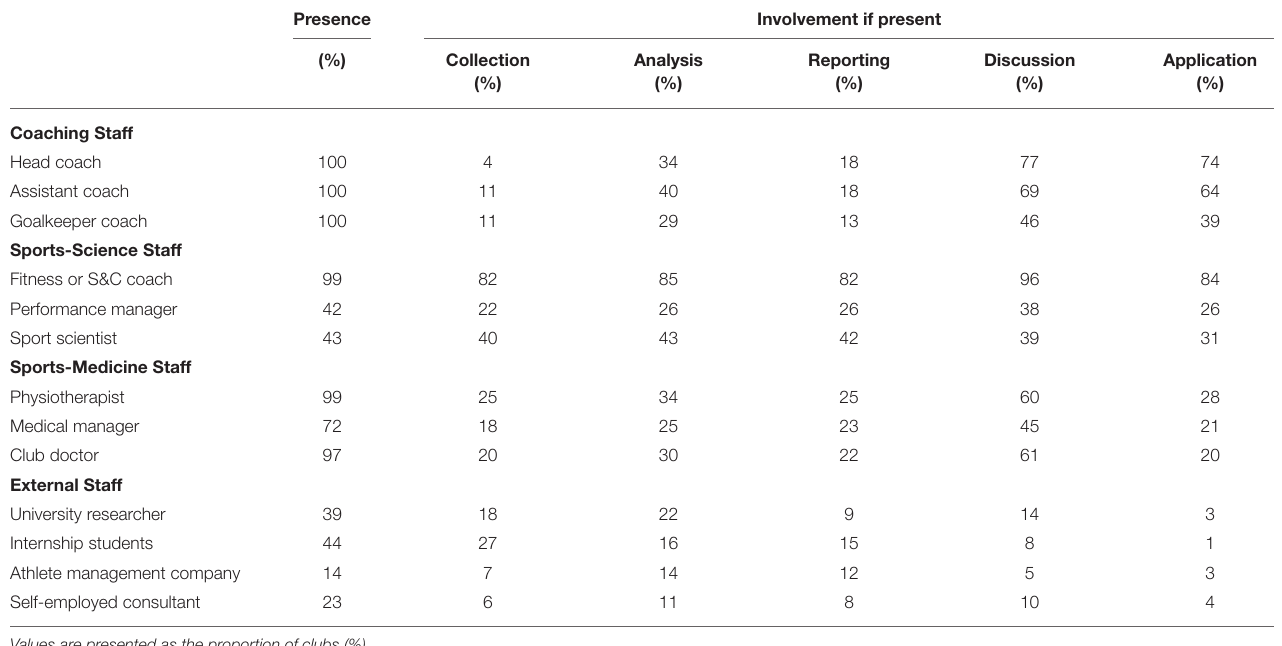
TABLE 3 | Presence and involvement of the different type of staff members in the different phases of the monitoring process.